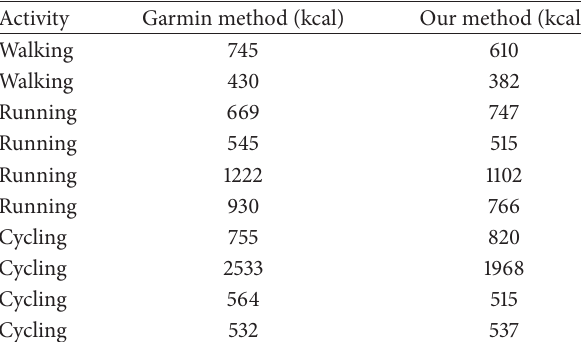
Table 6: Results of the System Usability Scale (SUS)